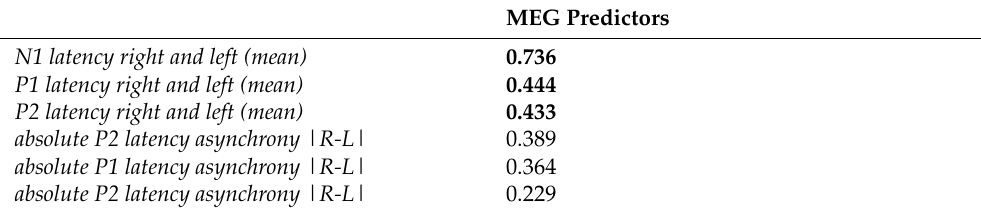
Table 2. The discriminant function of the MEG variables. The table shows the correlations of the outcome variables and the discriminant function of the MEG variables. We used the statistically accepted cutoff value of 0.40 to decide which of the variables were large enough to discriminate between the groups (see bold